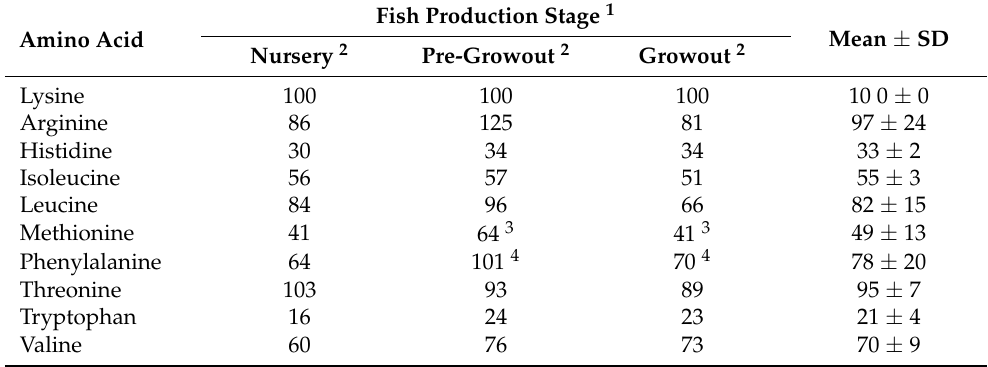
Table 5. Dietary amino acid profile (% of lysine) based on the ideal protein concept for Nile tilapia. Fish Production Stage Amino Acid